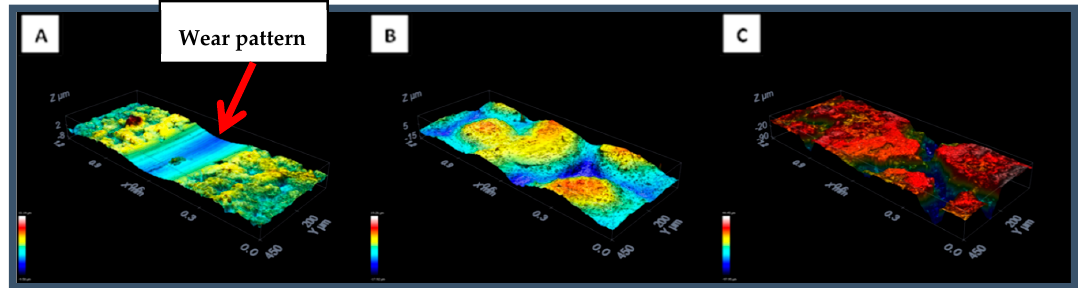
Figure 2. Time development of the coe ffi cient of friction (COF) measured against an alumina ball at an applied load of 7 N for PEEK, PEEK / BG, and PEEK / BG / h-BN coatings.